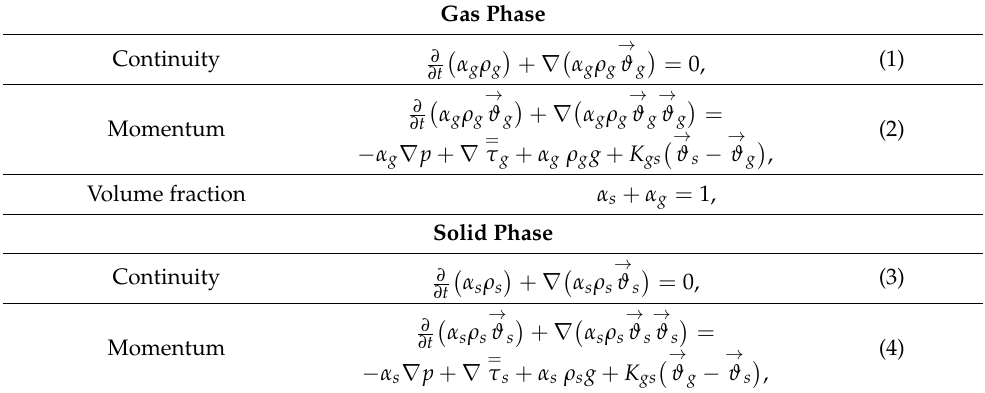
Table 1. Governing